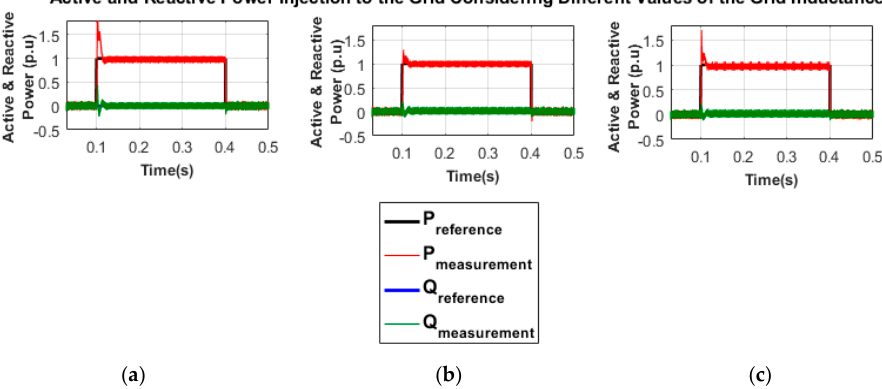
Figure 14. Different scenarios of active and reactive power injection: ( a ) When grid inductance, L g = 10 μ H; ( b ) When grid inductance, L g = 10 mH; ( c ) When L g = 5 mH.